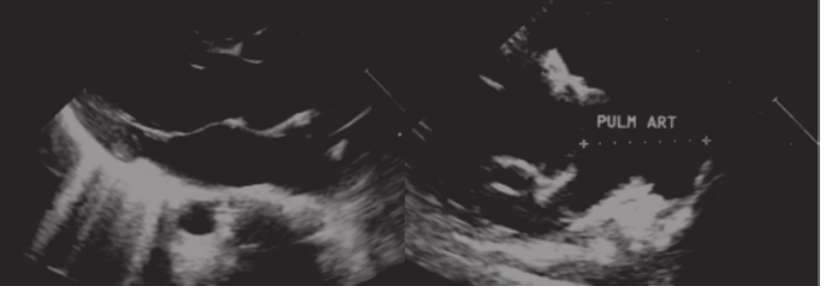
Figure 1. On the left long-axis parasternal view demonstrating aortic aneurysm; on the right parasternal short-axis that shows pulmonary artery aneurysm.